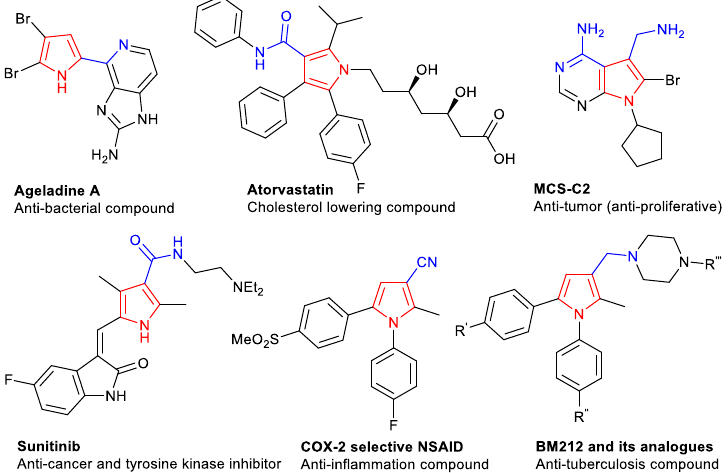
Figure 1. Examples of bioactive pyrrole-based compounds having a -CXN moiety (in blue).